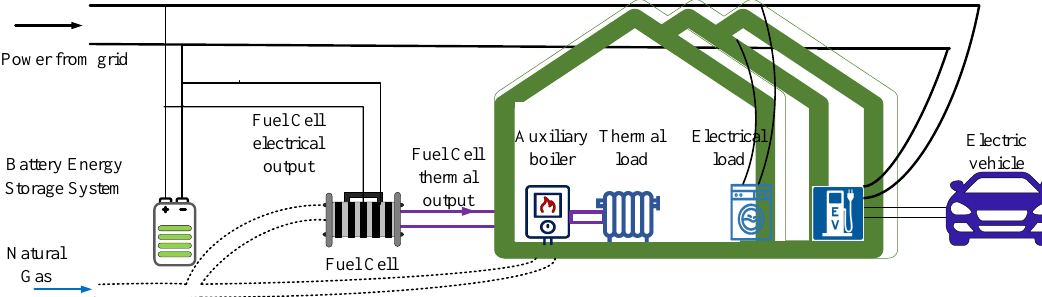
Figure 1. Overview of a smart